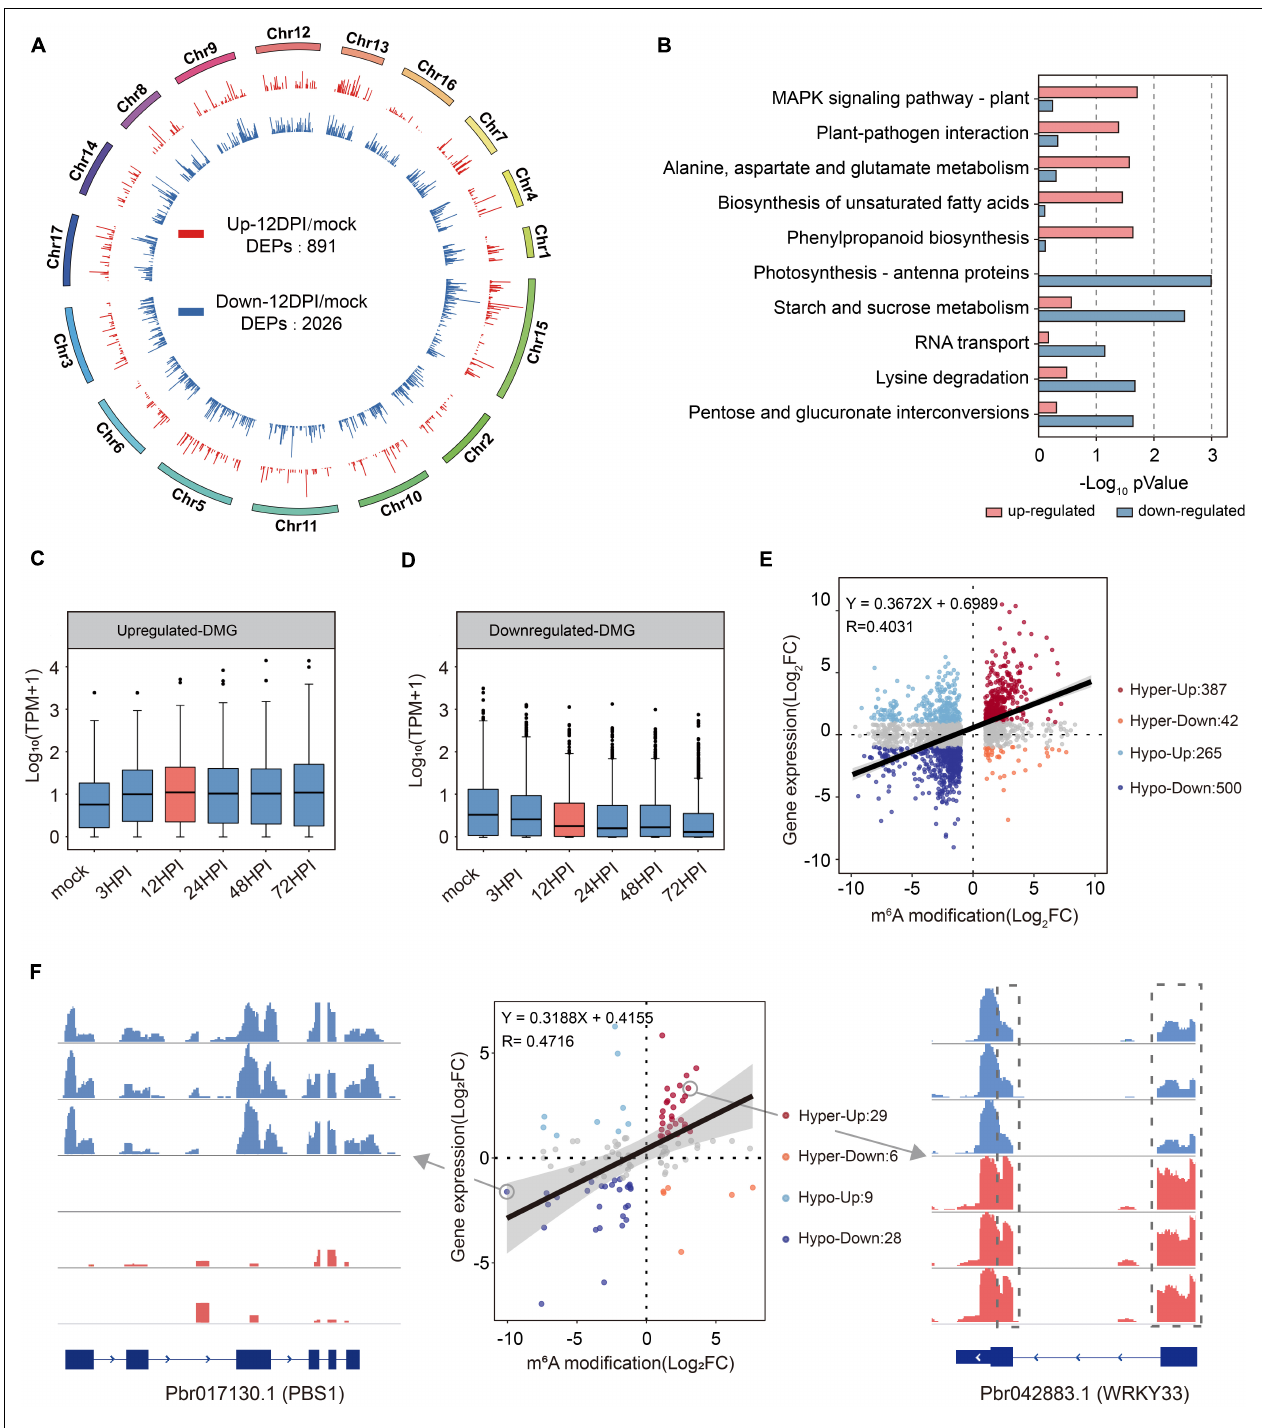
FIGURE 6 | Association analysis of MeRIP-seq and RNA-seq reveals that m 6 A-modification results in the increase of transcript abundance. (A) Circos plots of pear genome showing the relative abundance of m 6 A modification across 17 chromosomes. Upregulated methylated peaks are shown in red and downregulated methylated peaks are shown in blue. The kurtosis represents fold change of m 6 A abundance. (B) KEGG pathway enrichment analysis of upregulated and downregulated methylated genes. (C) Distribution of genes with a significant change in both the m 6 A level and the gene expression level in mock compared with 12 HPI. The linear regression equations and R 2 are shown on the graph. (D,E) Expression pattern of upregulated and downregulated methylated genes at different time points after inoculation. (F) Distribution of genes in plant–pathogen interaction KEGG pathway. Two genes were selected to present the browser views for m 6 A